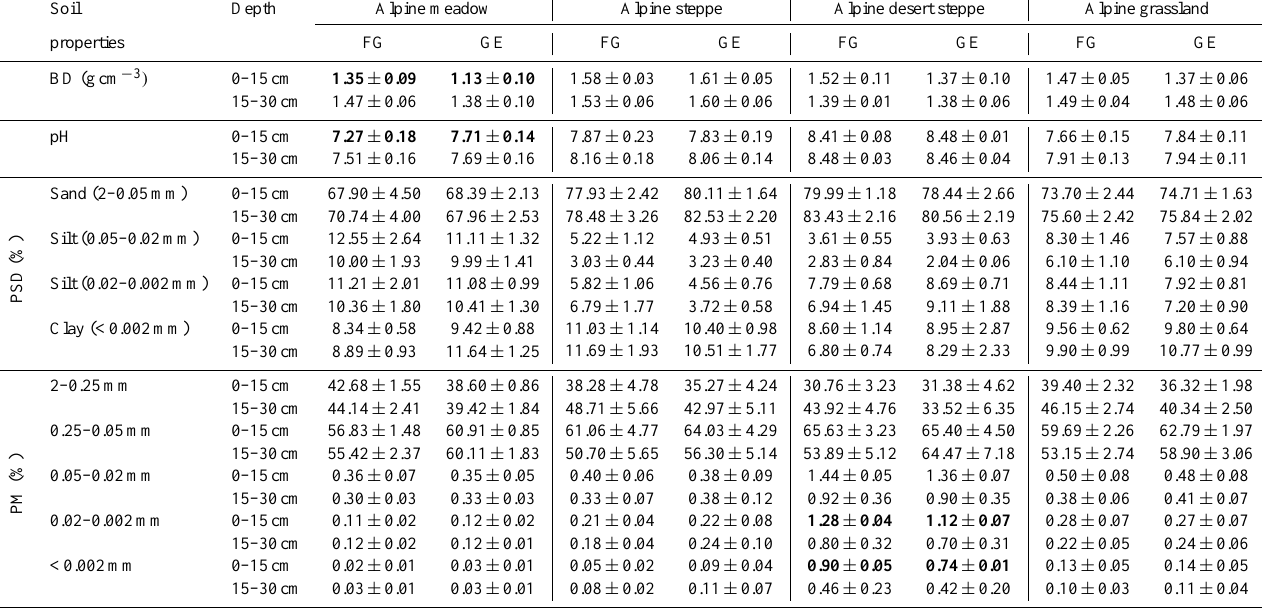
Table 1. Statistical comparison of overall mean values of soil properties ± standard error (SE) at 0–15 and 15–30cm depth using paired- difference t test ( α = 0 . 05) between free-grazing (FG) plots and grazing exclusion (GE) plots. P values below 0.05 are in bold. Soil